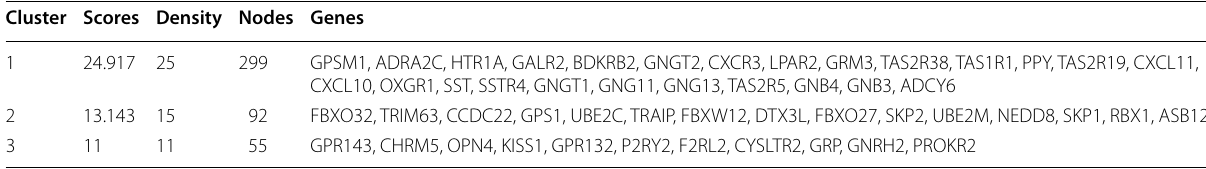
Table 4 Clusters of the PPI network of the DEGs in the DAU group Cluster Scores Density Nodes Genes